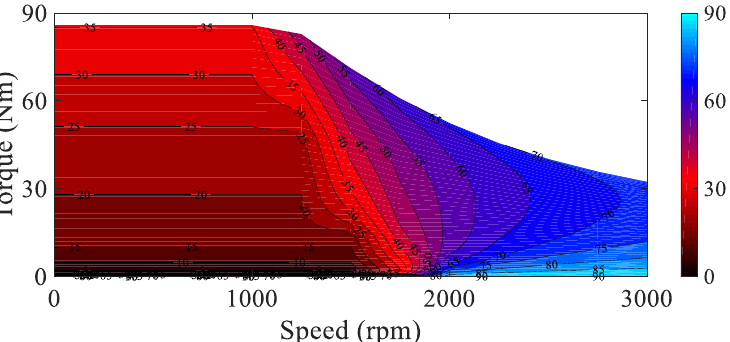
Figure 22. Phase Adv. (°) map of the Model-III. Table 4. Drive-Cycle Properties.